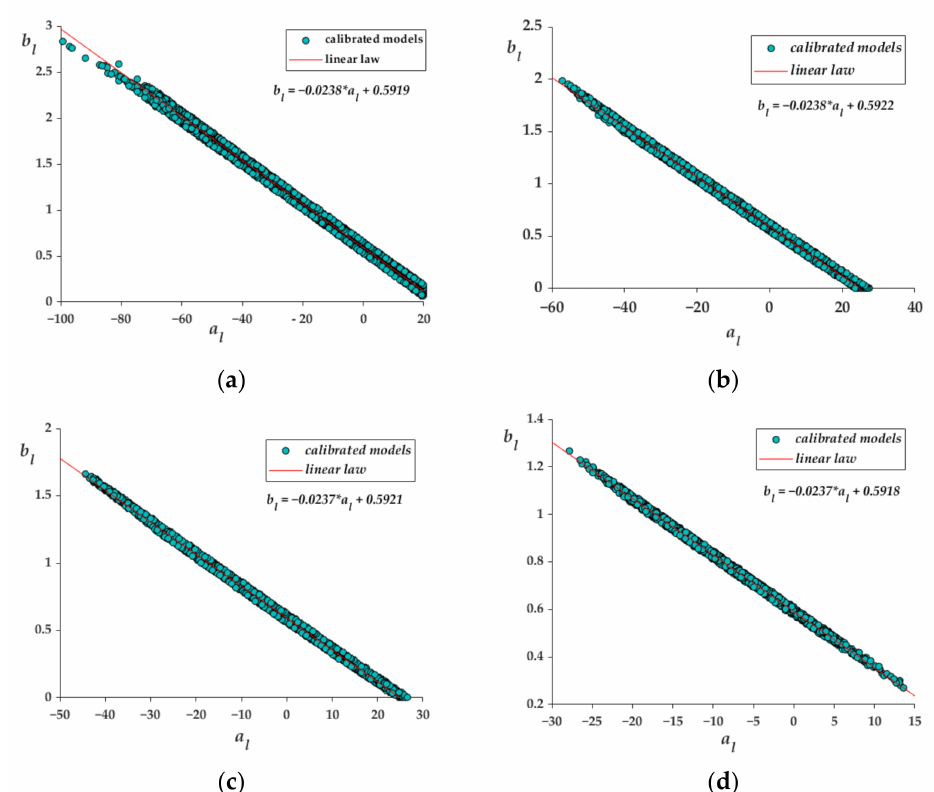
Figure 1. Relationship between the coefficients of the calibrated linear empirical laws b l vs. a l for different value of m considered data: ( a ) m = 11; ( b ) m = 15; ( c ) m = 18; ( d ) m = 22.